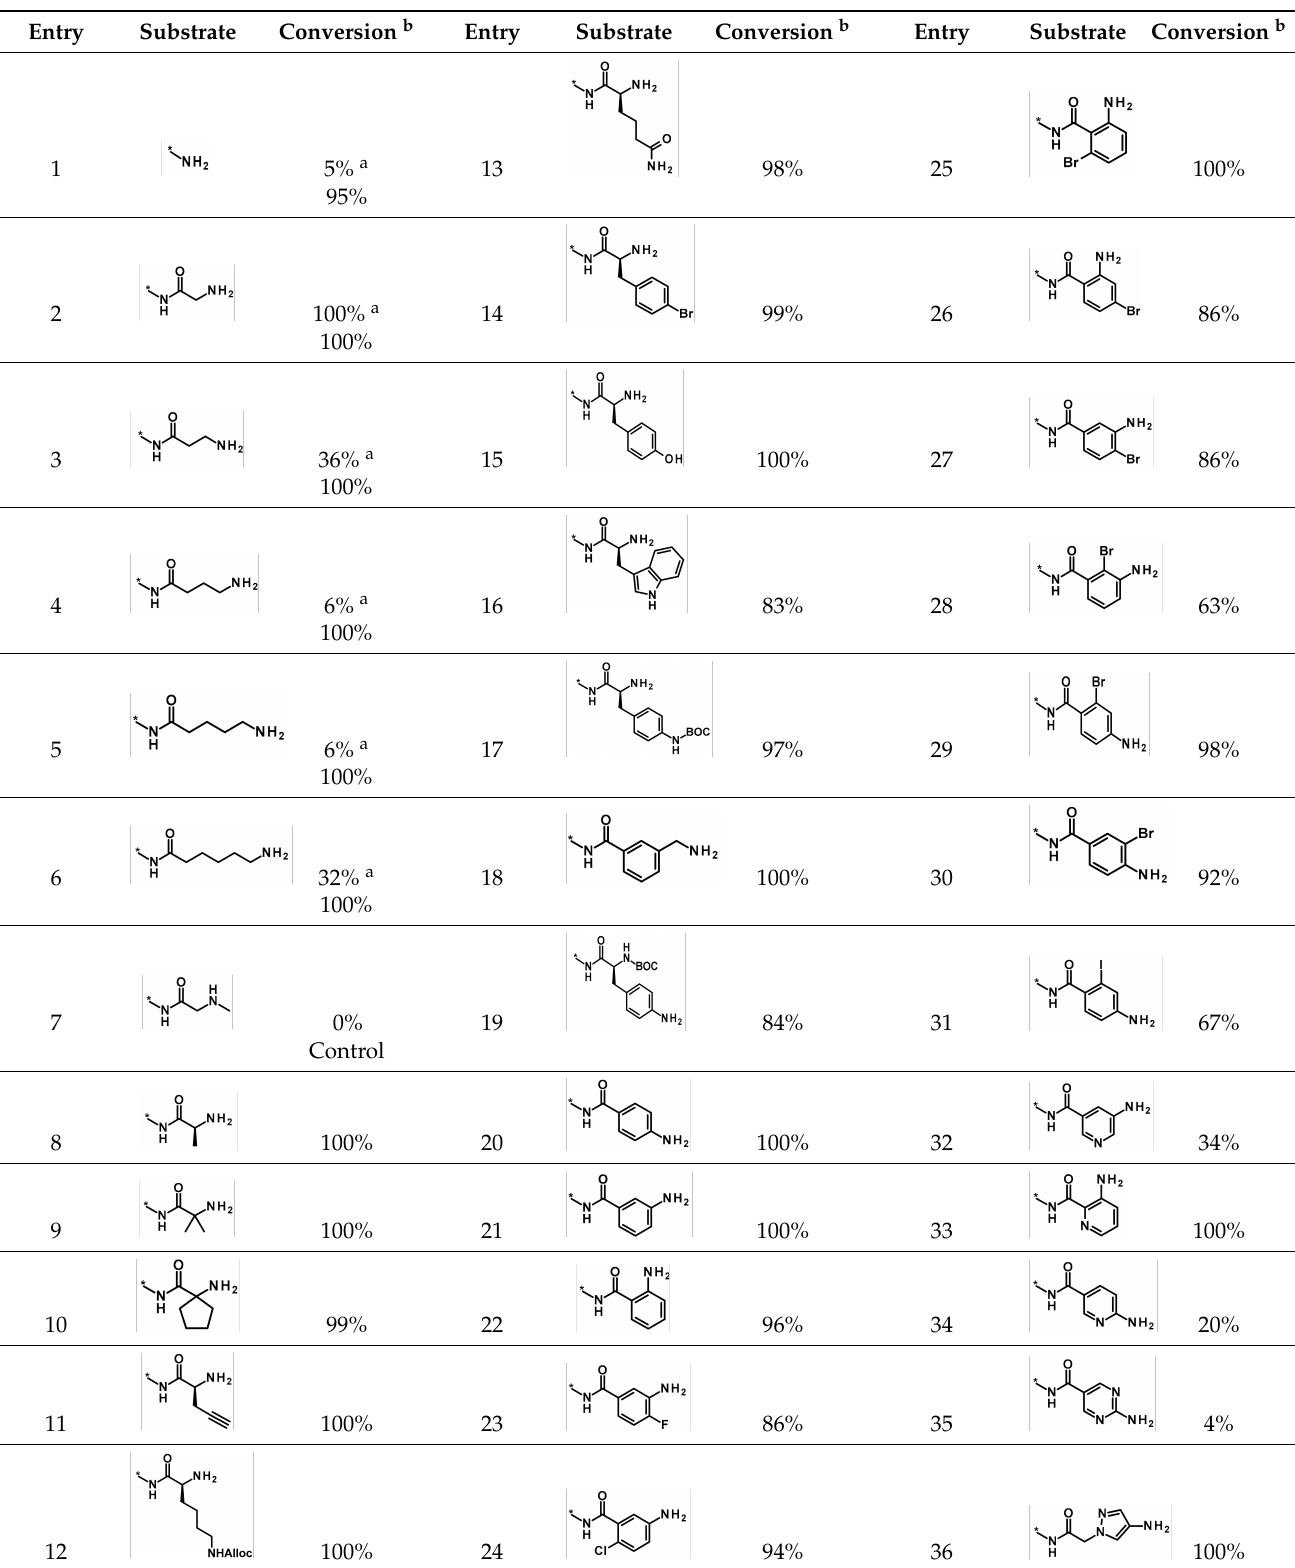
Table 2. Scope of the diazo-transfer reactions on DNA. Reactions conducted at 0.7 mM on 10 nmol scale using the optimized conditions in Table 1 (Entry